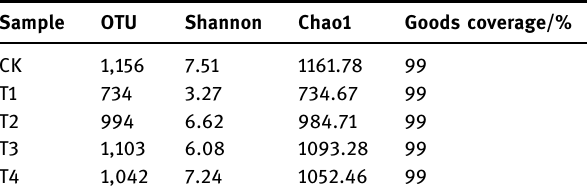
Table 2: Diversity indices of vermicompost bacterial communities and the control during hydrogen sul fi de treatment Sample